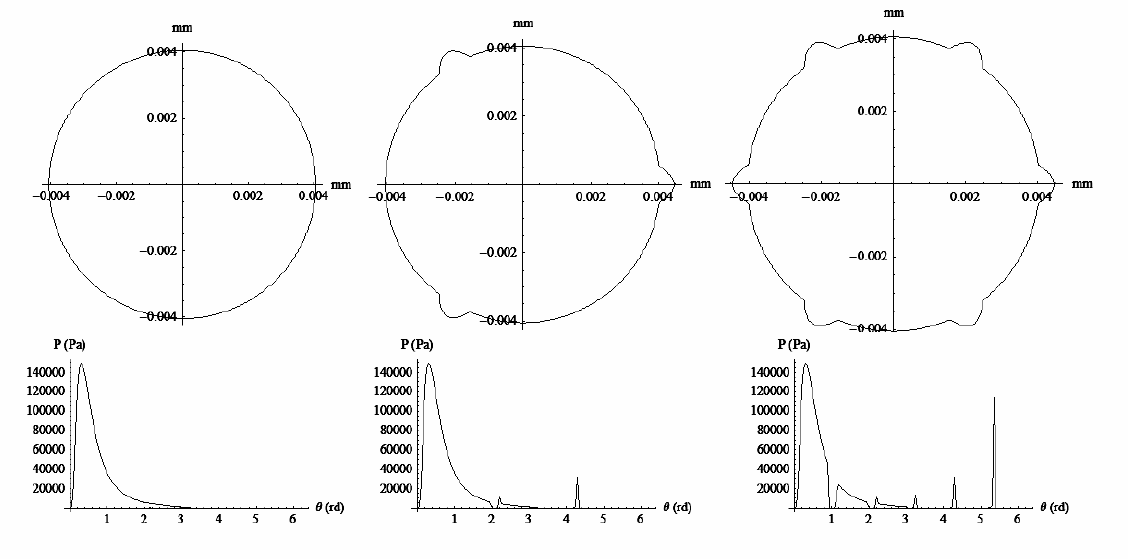
Fig. 3. Examples of orbits in different journal bearings and the corresponding pressure field.